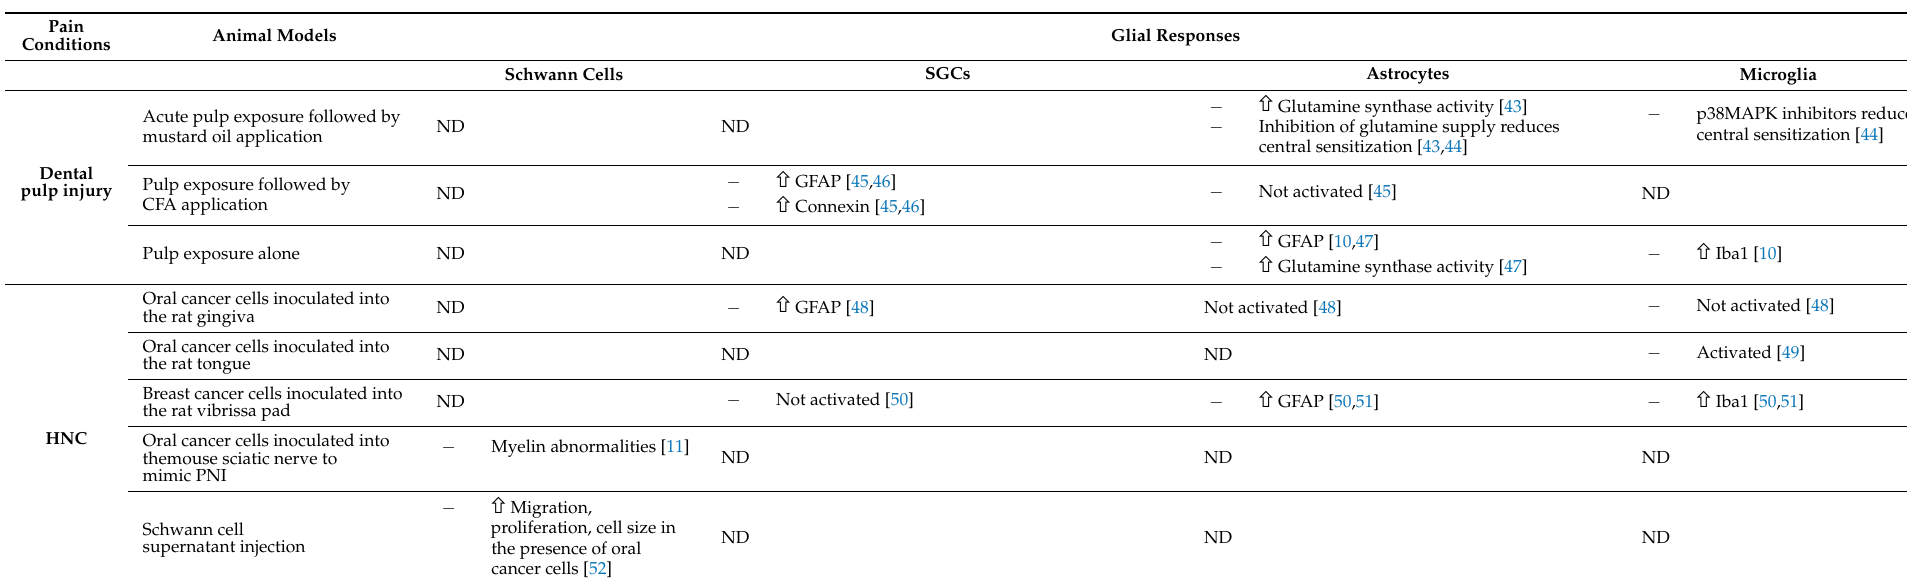
ND: No Data. Arrows: